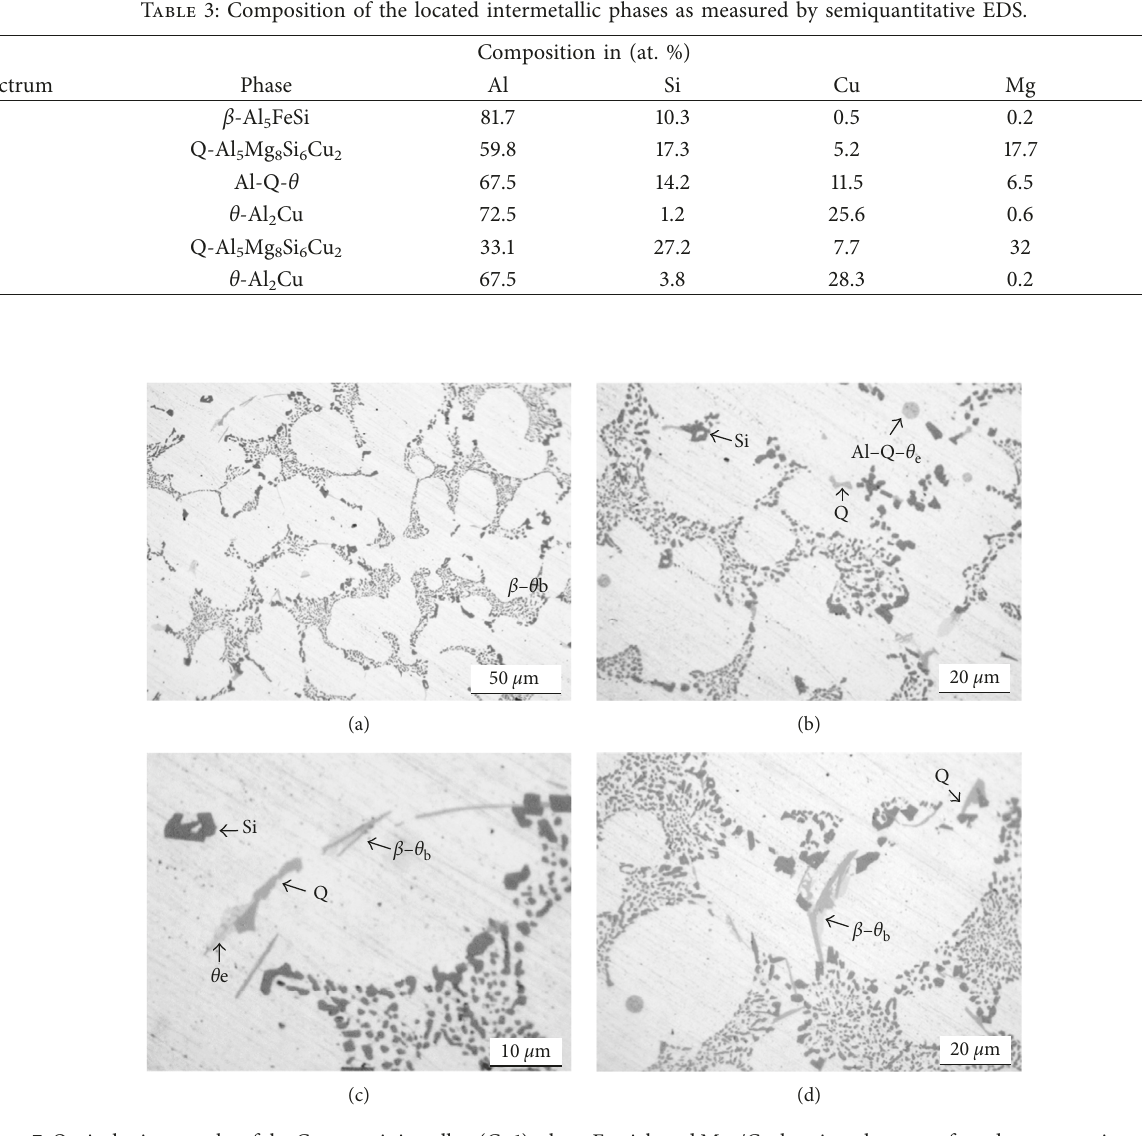
Figure 7: Optical micrographs of the Cu-containing alloy (Cu1) where Fe-rich and Mg-/Cu-bearing phases are found as companion to the Si